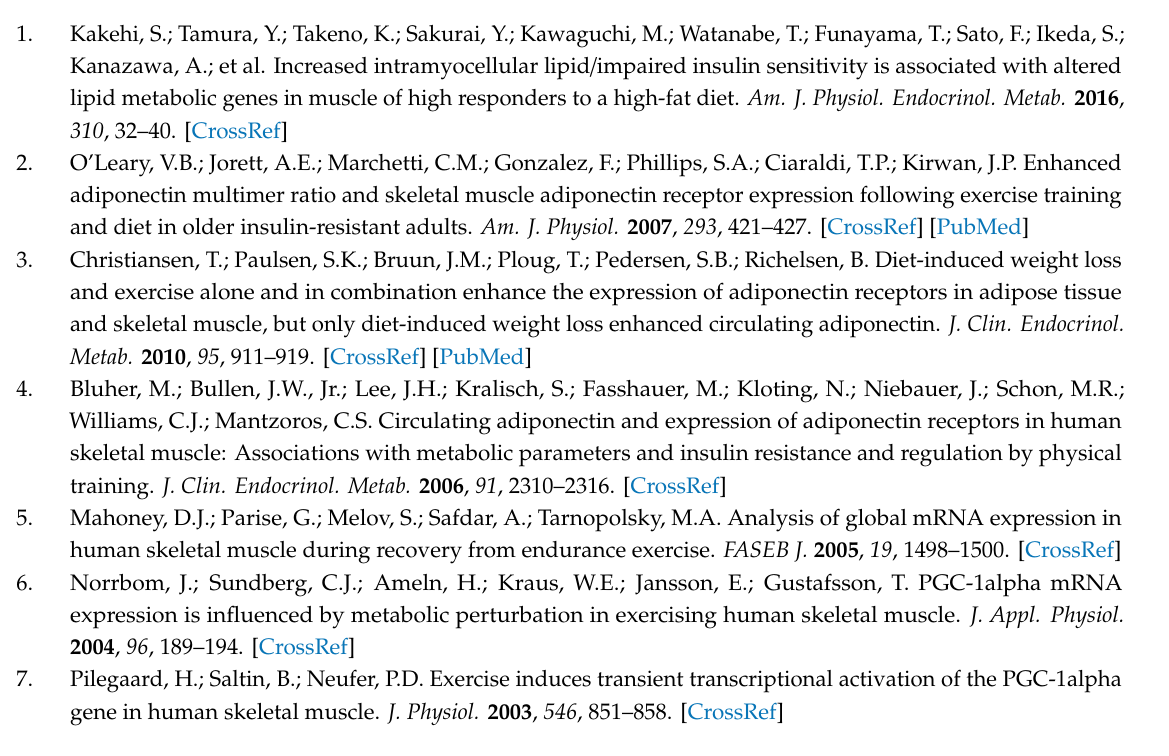
Table S1: Upregulated genes di ff erentially expressed in athletes ( p < 0.05 and 1.3-fold change), Table S2: Downregulated genes di ff erentially expressed in athletes ( p < 0.05 and -1.3-fold change), Table S3: Significantly upregulated Gene Ontology gene sets in the control group, Table S4: Significantly upregulated Gene Ontology gene sets in the athlete group, Table S5: Significantly upregulated Reactome Pathway gene sets in the control group, Table S6: Gene expression changes in “RESPONSE TO